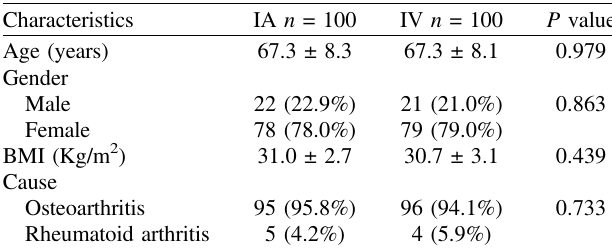
Table 1. Demographic features of study